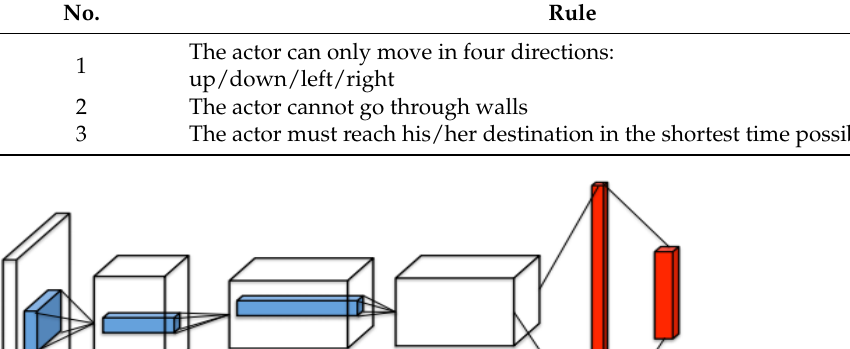
Figure 1. The structure of H-DQN. Table 1. Basic rules of the maze